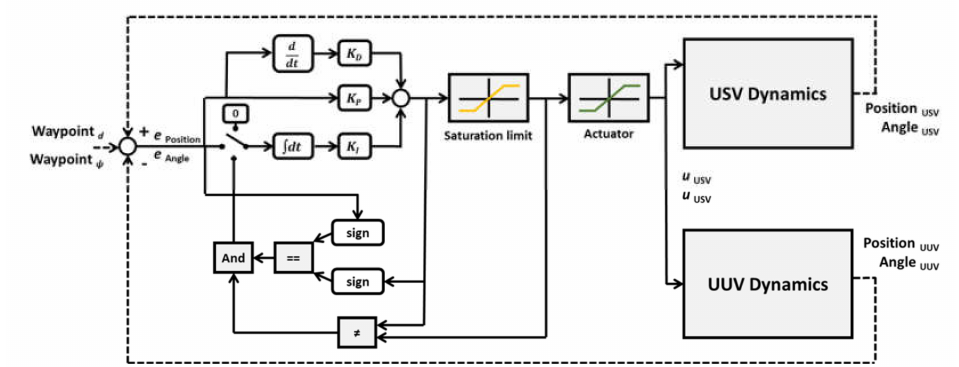
Figure 17. Diagram of the integrated platform coordination control